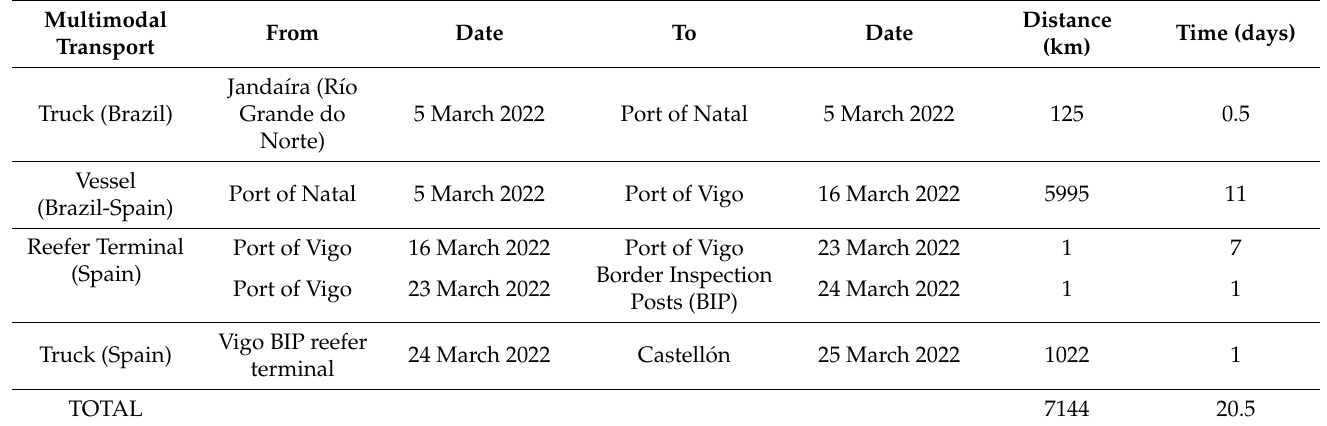
Table 1. Complete itinerary (Janda í ra, Brazil to Castell ó n, Spain) of the melon reefer.